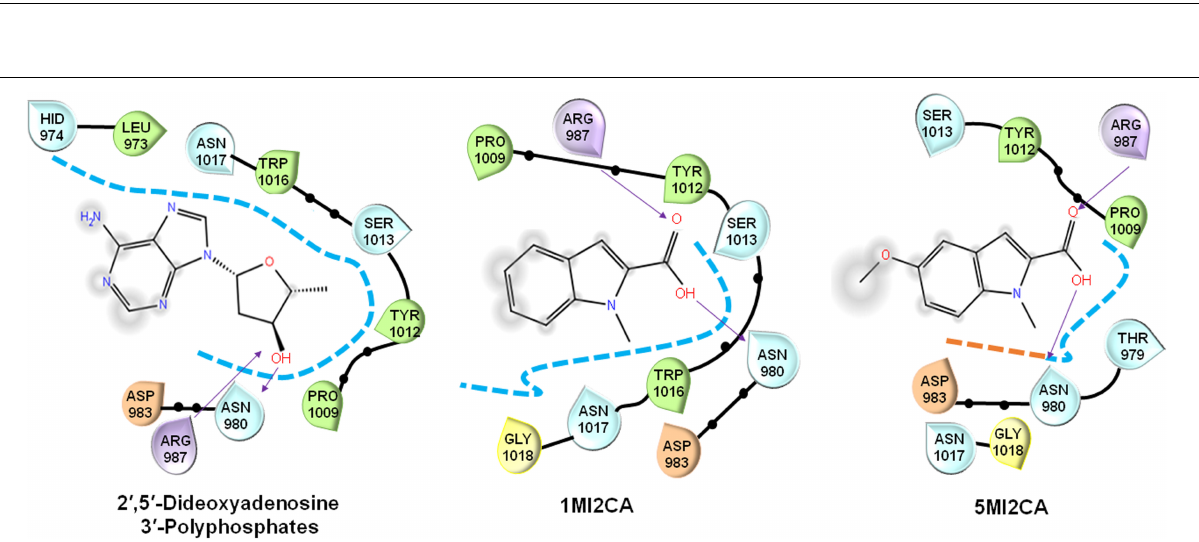
Frontiers in Microbiology |